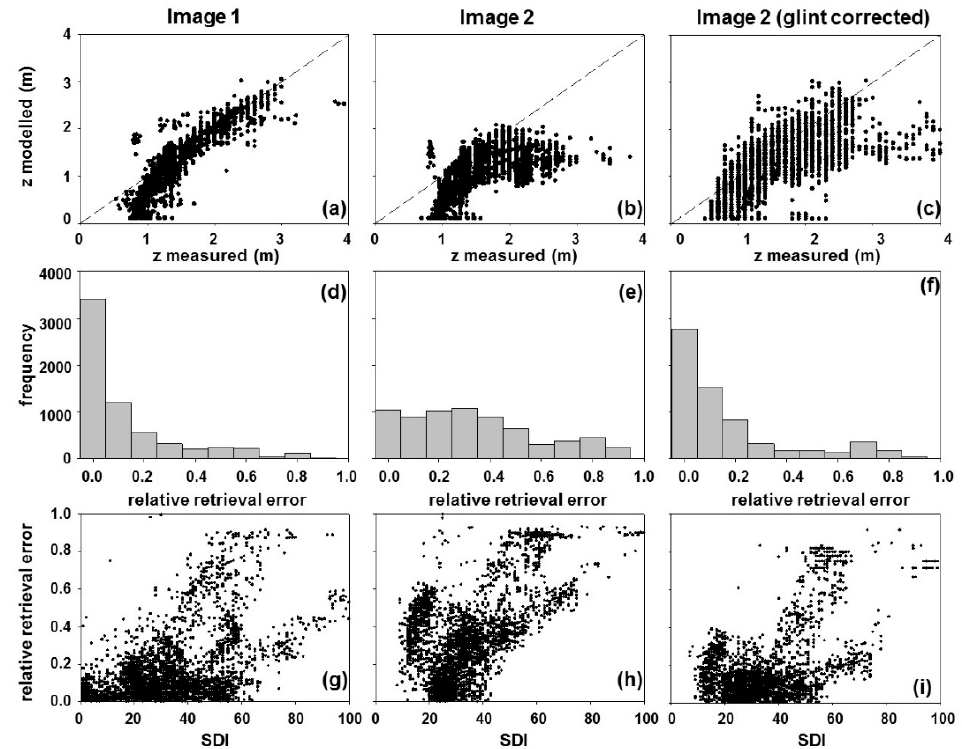
Figure 6. Analysis of depth retrieval: scatterplot of the model-estimated depth versus in situ depth observations retrieved from ( a ) Image 1; ( b ) Image 2 and ( c ) Image 2 after glint correction (dashed line represents 1:1 relationship). Histogram of the frequency of absolute relative depth errors ( |p measured z ´ modeled z q|{ measured z ), retrieved from ( d ) Image 1; ( e ) Image 2; and ( f ) Image 2 after glint correction. Scatterplot of relative depth error versus SDI retrieved from ( g ) Image 1; ( h ) Image 2; and ( i ) Image 2 after glint correction.